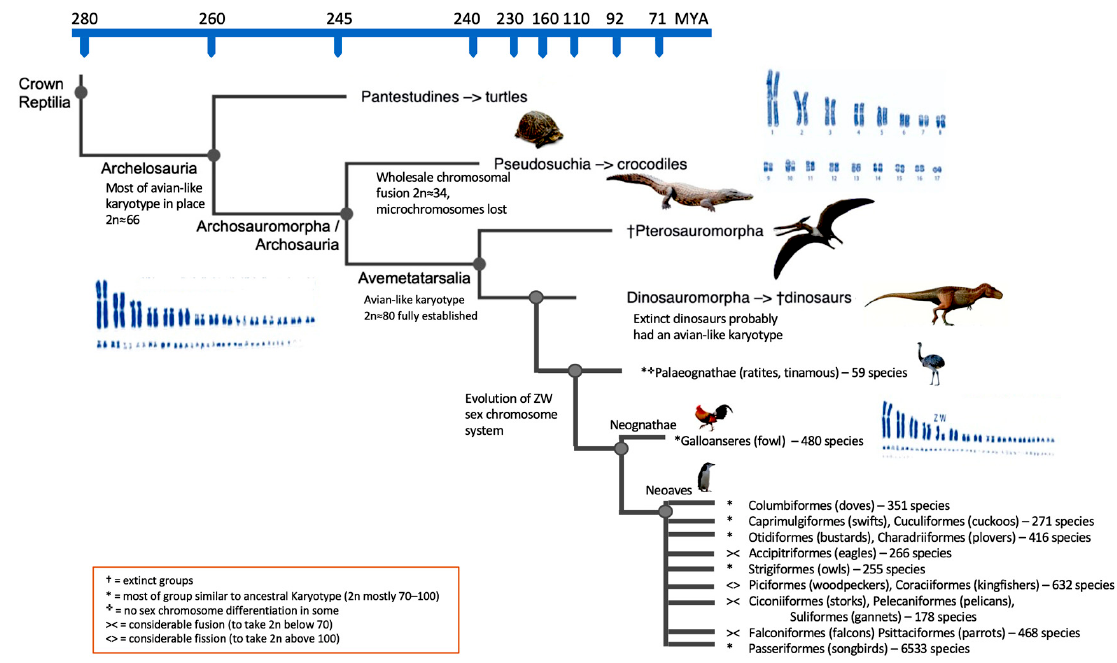
Figure 2. Cladogram of the major evolutionary reptilian groups including dinosaurs and several groups of birds. Likely karyotypic changes given, time scale is not linear.